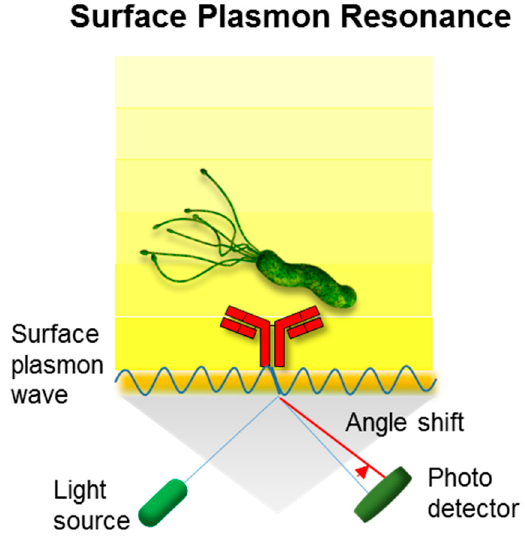
Figure 3. Schematic representation of the optical approach based on surface plasmon resonance (SPR). This system is performed with a light source and thin metallic material (e.g., Au). An electromagnetic light wave can be coupled with a surface plasmon wave and change the angle shift of the reflected light, which is the result of the binding between the antibody and pathogen. This detection tool can be utilized for the real-time monitoring of sample pathogens.